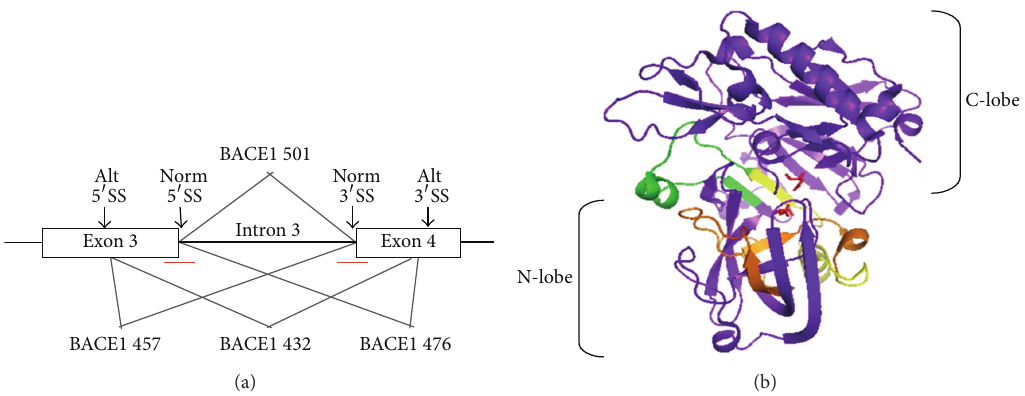
Figure 7: BACE1 alternative splicing and targeting by antisense oligonucleotides. (a) Alternative splice sites in exons 3 and 4 of BACE1 mRNA. The amino acid length of each isoform upon translation to protein is indicated. Red lines indicate antisense oligonucleotides targeted to the normal 5 󸀠 and 3 󸀠 splice sites. (b) Structure of BACE1 showing the N- and C-terminal lobes, with the active site at the interface. Colored regions are parts of the full-length BACE1 enzyme that would be deleted in alternative splice isoforms. Note that these sites are in and around the active site and would be expected to affect the folding and final conformation of the enzyme.